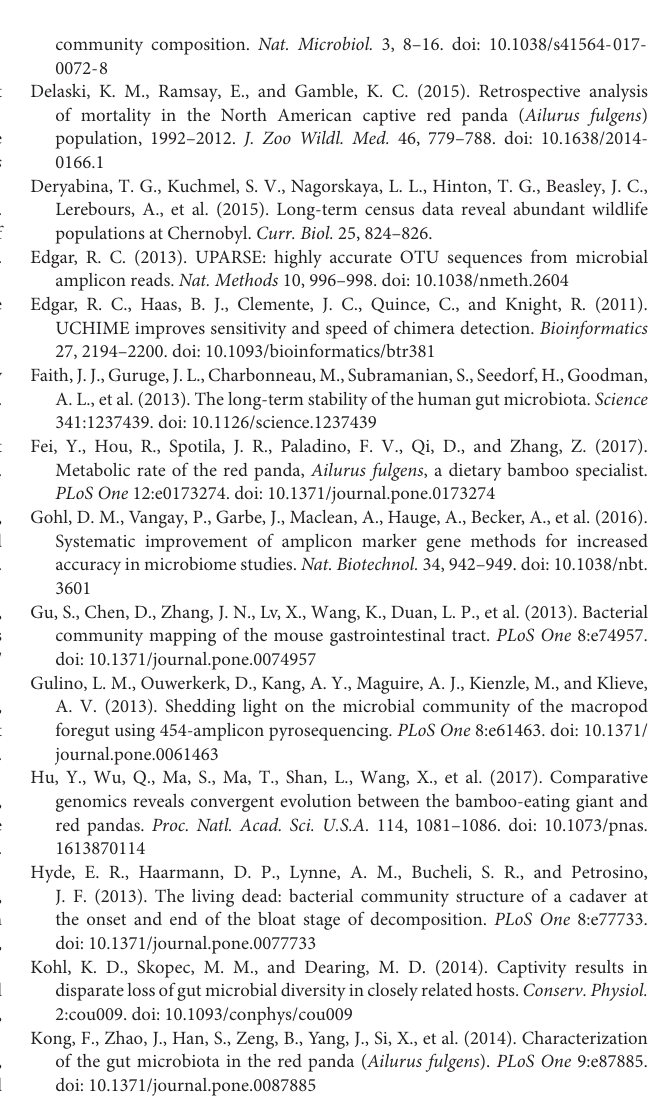
FIGURE S5 | Species annotation of microbiota of red panda GIT at levels from (A) phylum, (B) class, (C) order, (D) family, and (E) genus. TABLE S1 | General information of sequence data. Sto, Duo, Jej, Ile, Col, Rec, and Fae represent samples from the stomach, duodenum, jejunum, ileum, colon, rectum, and faecal, respectively. TABLE S2 | Alpha diversity index, including observed species, Shannon, Simpson, chao1, ACE, and goods coverage. Sto, Duo, Jej, Ile, Col, Rec, and Fae represent samples from the stomach, duodenum, jejunum, ileum, colon, rectum, and faecal, respectively. TABLE S3 | Core bacterial average sequence in red panda GIT. Sto, Duo, Jej, Ile, Col, Rec, and Fae represent samples from the stomach, duodenum, jejunum, ileum, colon, rectum, and faecal, respectively. TABLE S4 | Unique bacterial genus from the stomach, duodenum, jejunum, ileum, colon, rectum, and faecal samples, respectively. Sto, Duo, Jej, Ile, Col, Rec, and Fae represent samples from the stomach, duodenum, jejunum, ileum, colon, rectum, and faecal, respectively. TABLE S5 | Dominant bacterial community at the classification level from phylum to genus in red panda